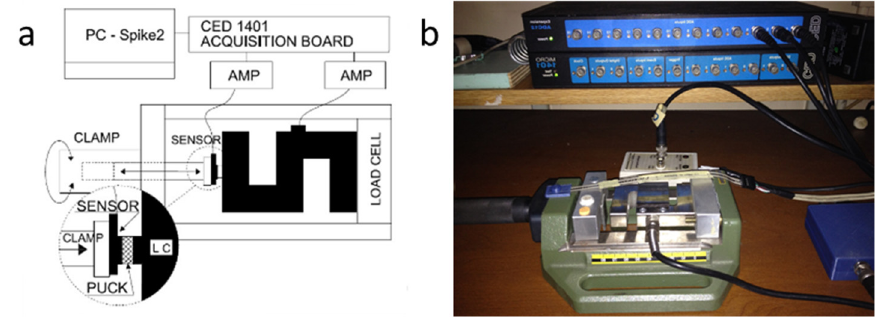
Figure 2. Scheme ( a ) and picture ( b ) of the experimental setup. LC: load cell, AMP: signal conditioning and amplification for both the sensor and the load cell.